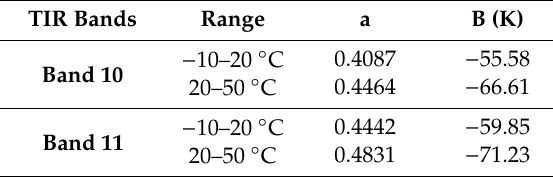
Table 2. Linear regression coe ffi cients for the parameters L 10 and L 11 .